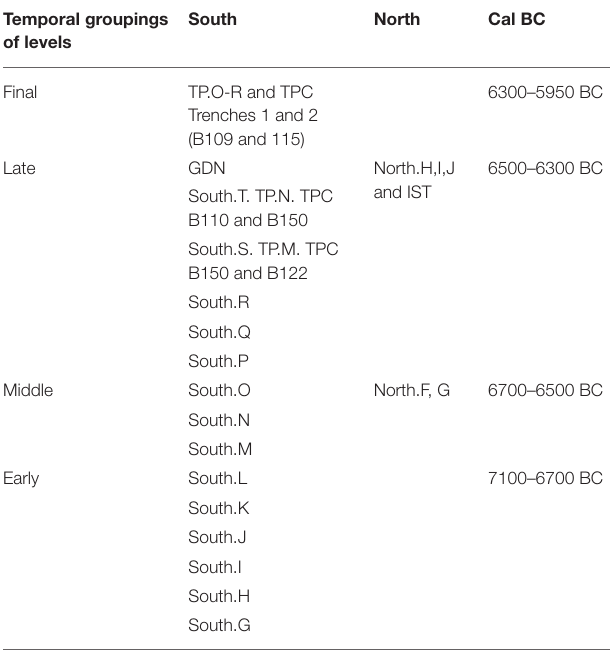
TABLE 2 | Çatalhöyük phases/levels and macro-phases used as chronological frame in network construction (early, middle, late). Temporal groupings of